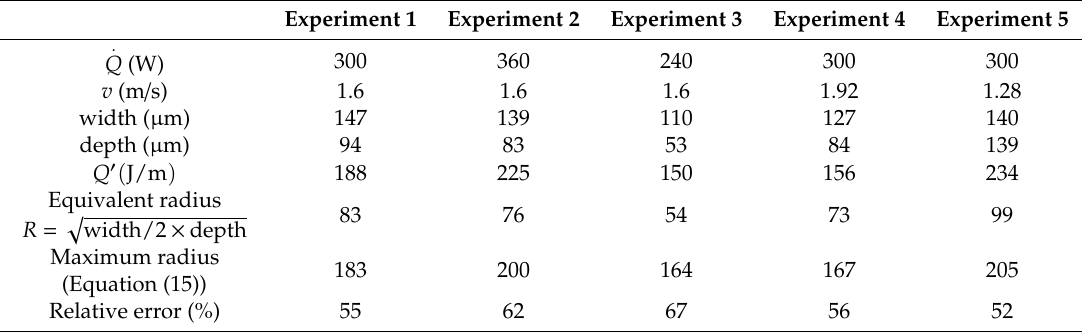
Table 1. SLM experiments using the alloy IN718. In the table we show the data of the five experiments, the energy per unit length delivered by the laser, and the upper bound (i.e., the maximum possible radius of molten material).